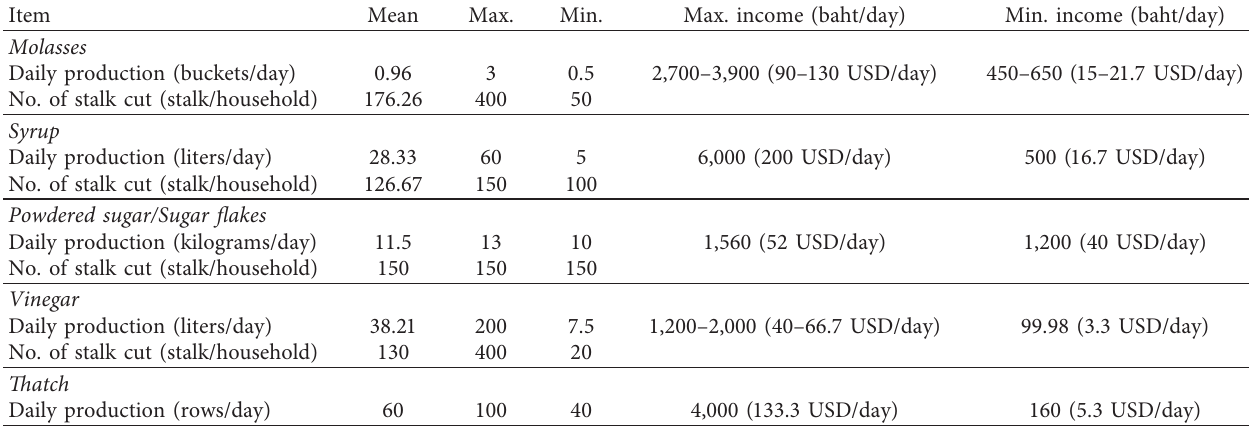
Table 1: Products from nipa palm in Khanap Nak.